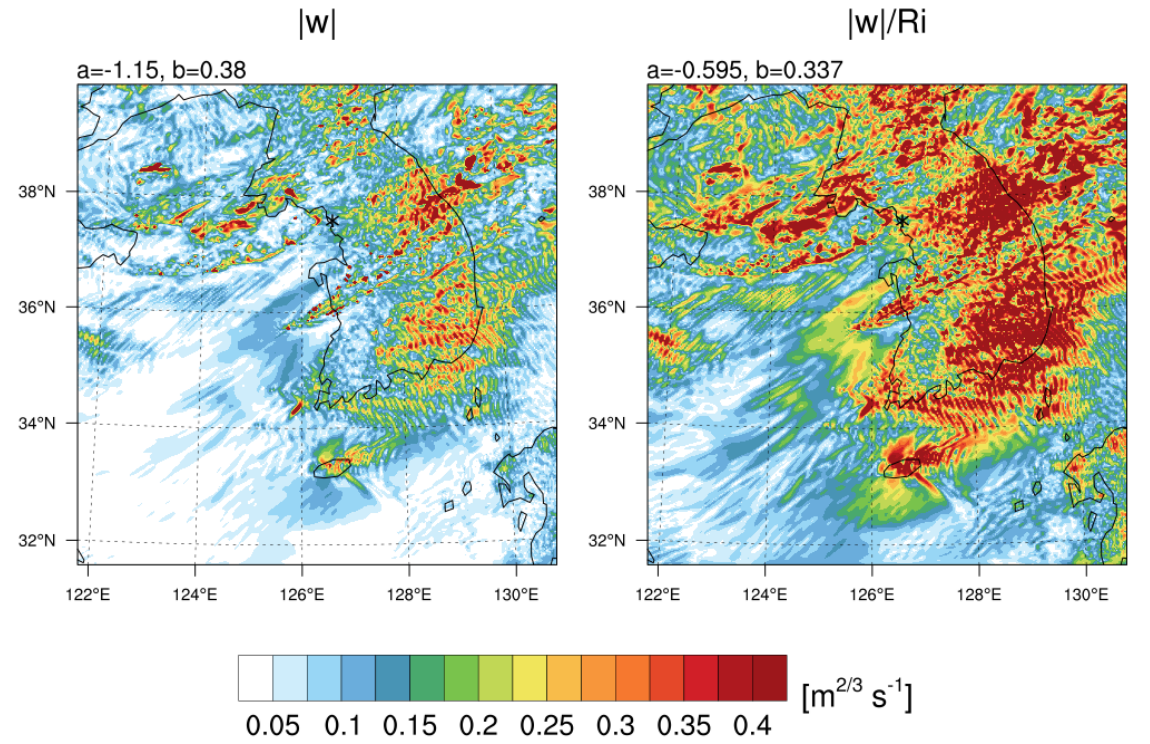
Figure 15. Horizontal distribution of the EDR converted from (left) the absolute value of vertical velocity |w| and (right) |w|/Ri at 06:40 UTC on 28 October 2018 at z = 2.2 km. The asterisk indicates the location of the CIT event.